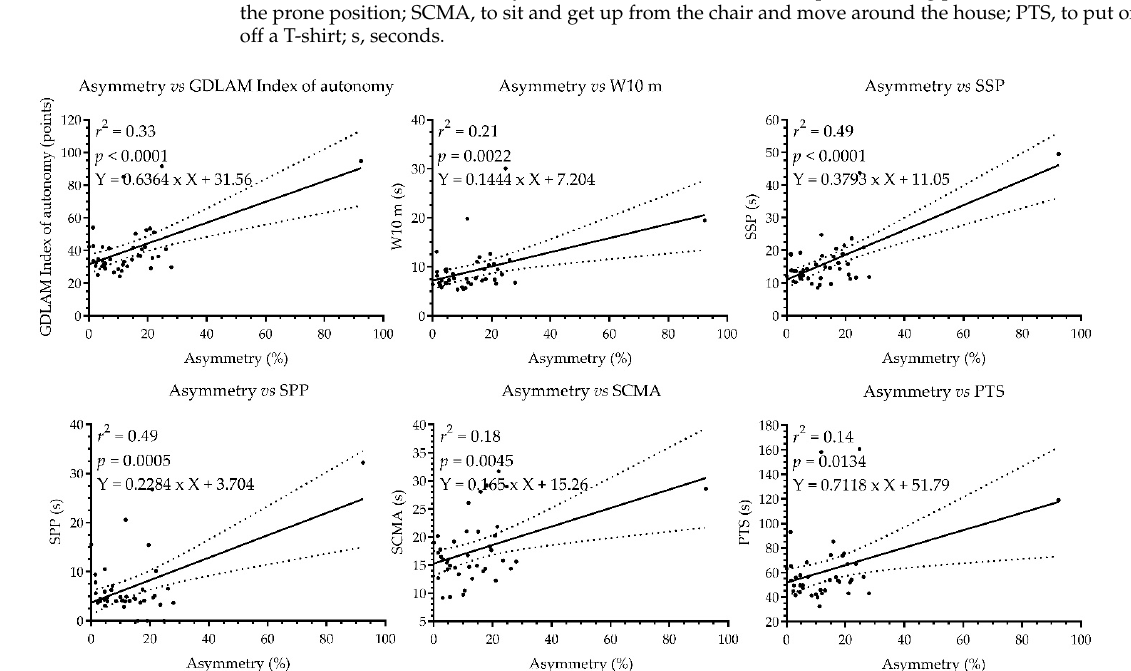
Figure 3. Correlation analysis between the asymmetry and GDLAM’S Protocol. W10 m, walk